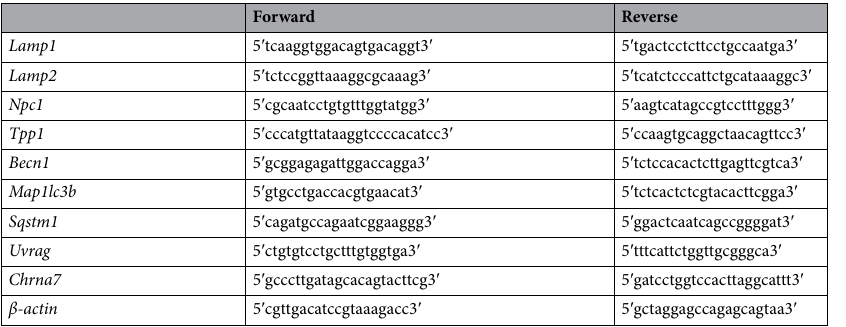
Table 1. Primer pairs used for qRT-PCR. Lamp1 lysosome-associated membrane protein 1, Lamp2 lysosome- associated membrane protein 2, Npc1 NPC intracellular cholesterol transporter 1, Tpp1 tripeptidyl peptidase 1, Becn1 Beclin1, Map1lc3b microtubule associated protein 1 light chain 3 beta, Sqstm1 Sequestosome 1, Uvrag UV radiation resistance associated, Chrna7 cholinergic receptor nicotinic alpha